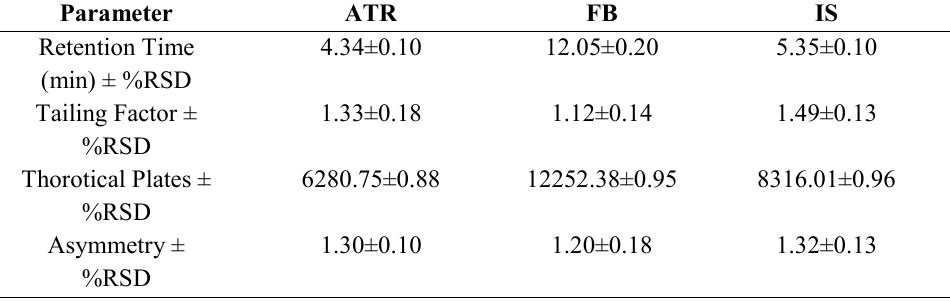
Figure 1: Representative chromatograms of ATR (10 µg /ml), FB (160 µg /ml) and IS. Table 1: System Suitability Test parameter for ATR, FB and IS (n